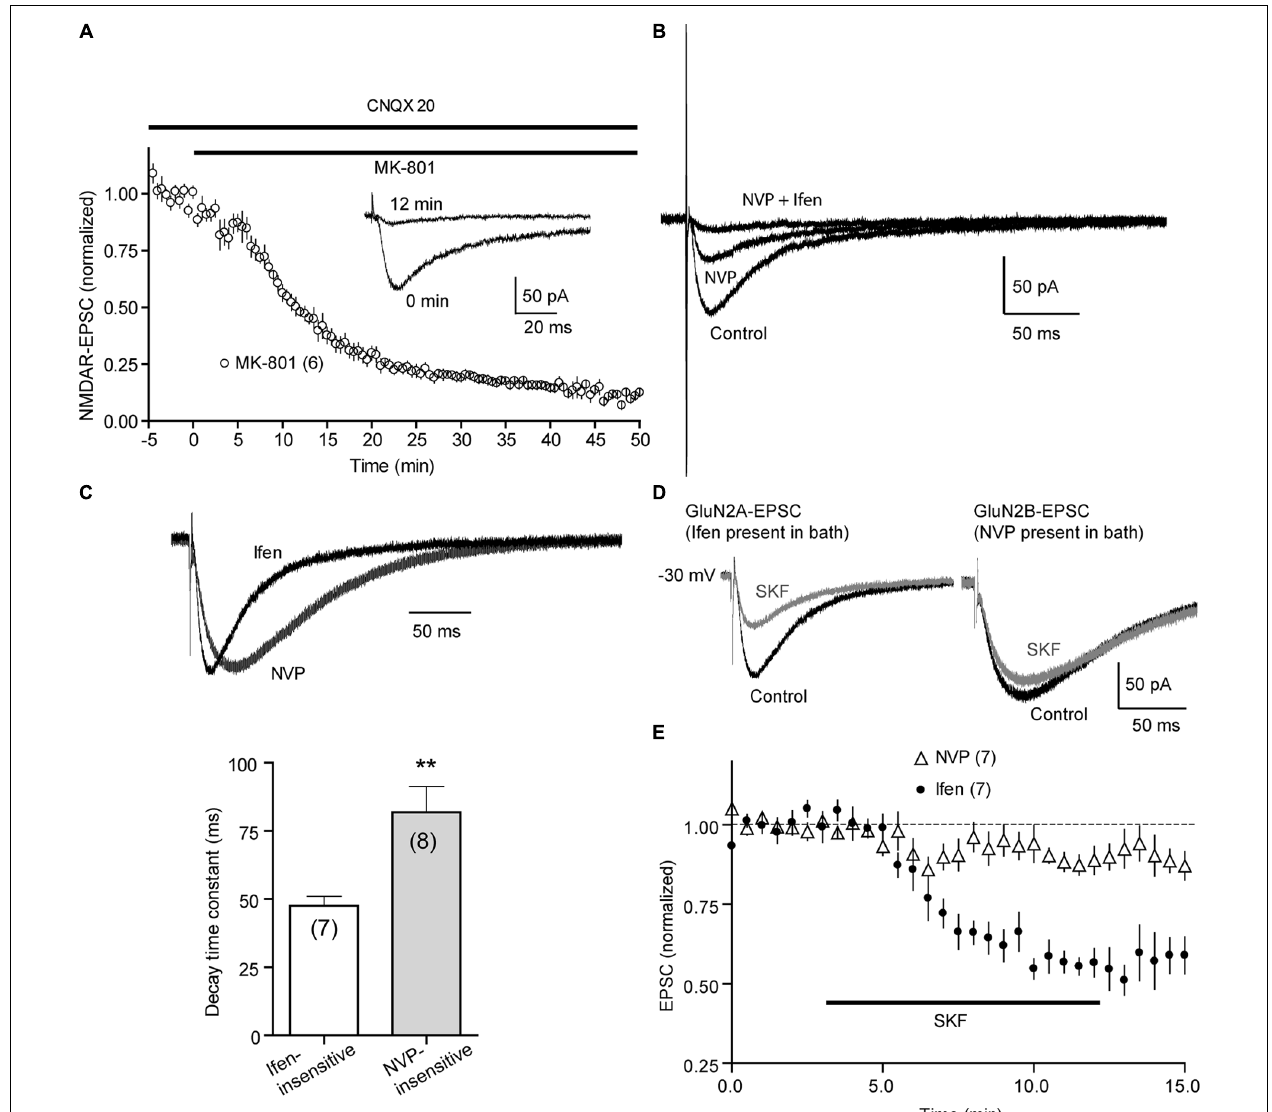
FIGURE 6 | Effects of SKF81297 on GluN2A- and GluN2B-mediated synaptic NMDAR currents. (A) Progressive blockade of synaptic NMDAR current by MK-801. NMDA-EPSCs were recorded at − 30 mV. Picrotoxin (50 μ M) and CNQX (20 μ M) were present in the bath to block GABA A and AMPA receptor currents, respectively. MK-801 (20 μ M) was added to the bath at 0 min. Insets, representative traces show NMDA-EPSCs at 0 and 12 min following MK-801 application. (B) PFC NMDA-EPSCs were composed primarily of GluN2A and GluN2B currents, as sequential addition of NVP-AAM077 (NVP; 0.4 μ M) and ifenprodil (Ifen; 3 μ M) abolished, most, if not all NMDA-EPSCs. Representative traces were shown. (C) Isolation of GluN2A- and GluN2B-mediated NMDAR currents. NVP-AAM077 or ifenprodil was